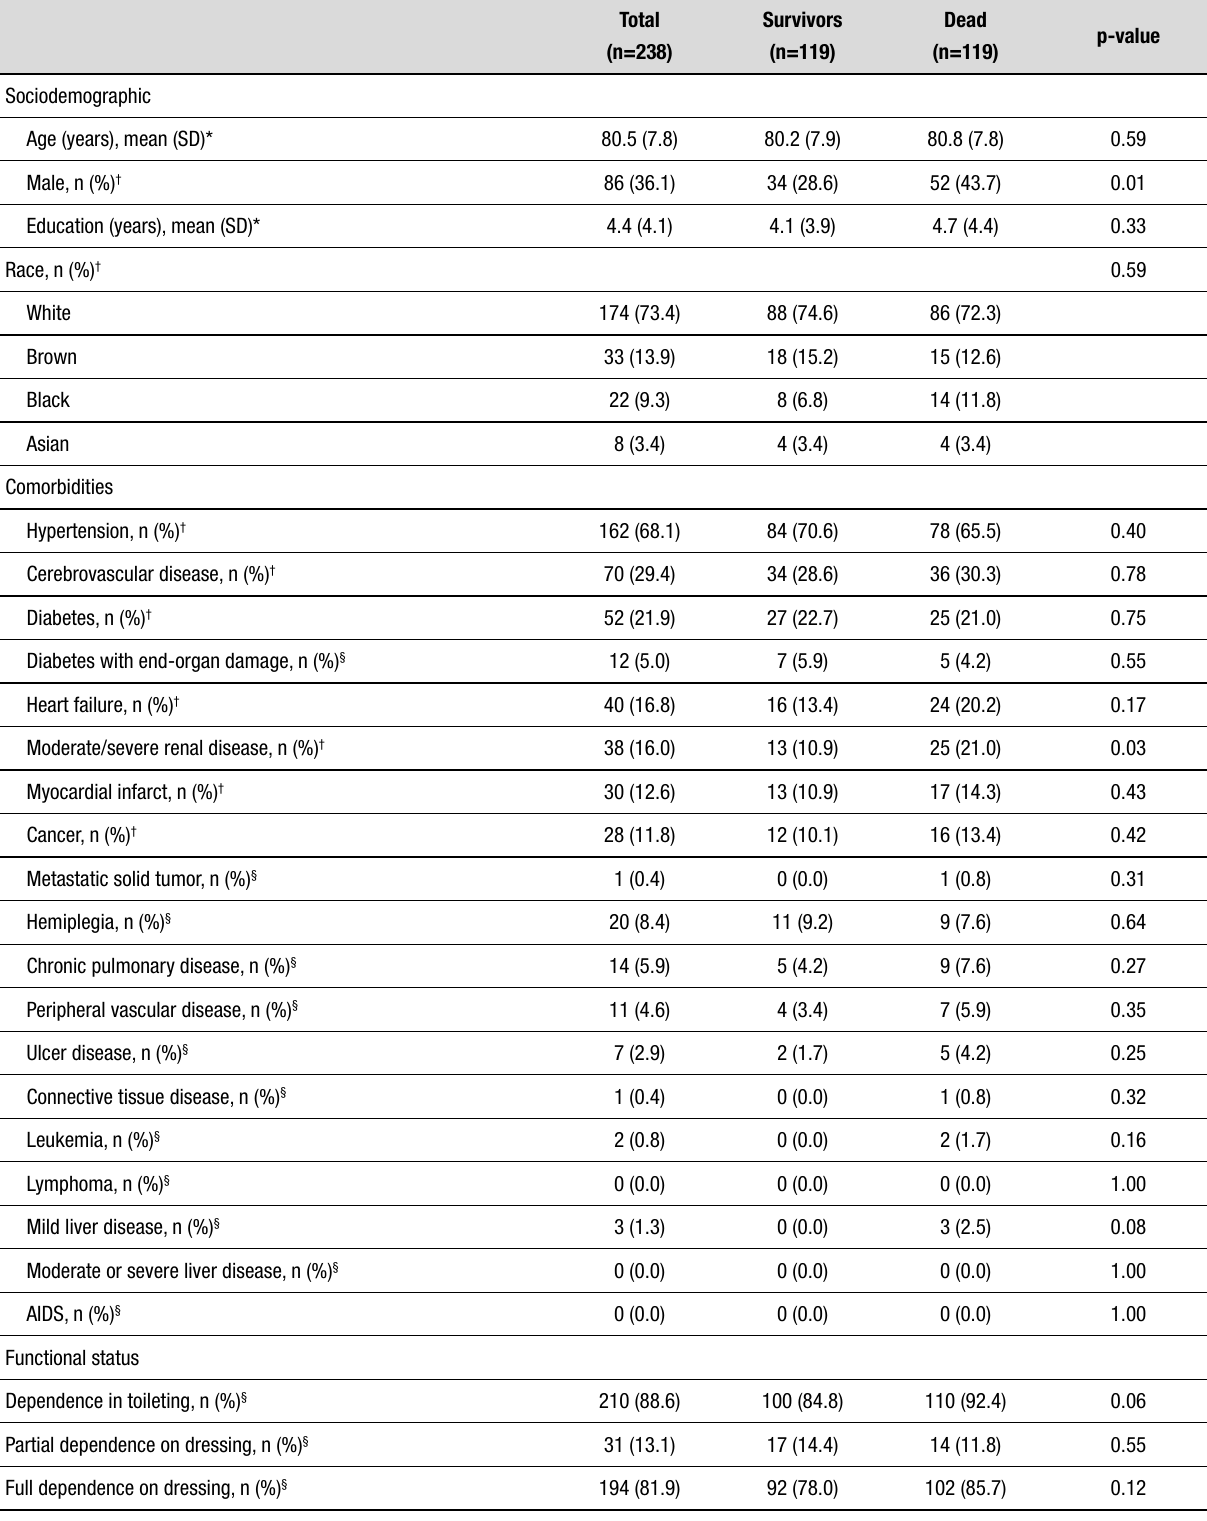
Table 1. Baseline characteristics of study participants